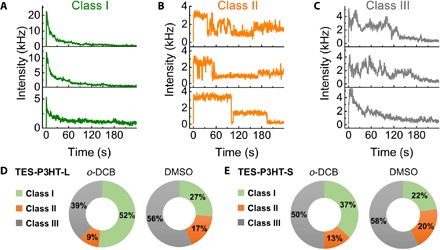
Single-molecule analysis of surface-anchored TES-P3HT-L polymers in good (o-DCB) and poor solvents (DMSO).Single-molecule PL intensity traces were classified into three classes (I to III). (A) Representative single-molecule class I traces obtained for TES-P3HT-L displaying a continuous decrease in PL intensity. (B) Representative single-molecule class II traces. Class II traces were characterized by multilevel fluctuations in PL intensity. (C) Representative single-molecule class III traces obtained for TES-P3HT-L displaying a hybrid PL profile combining regions of continuous decrease in PL intensity and regions with multilevel fluctuations. Statistical contributions of each class obtained in o-DCB (good solvent) and DMSO (poor solvent) are shown for TES-P3HT-L (D) and TES-P3HT-S (E).